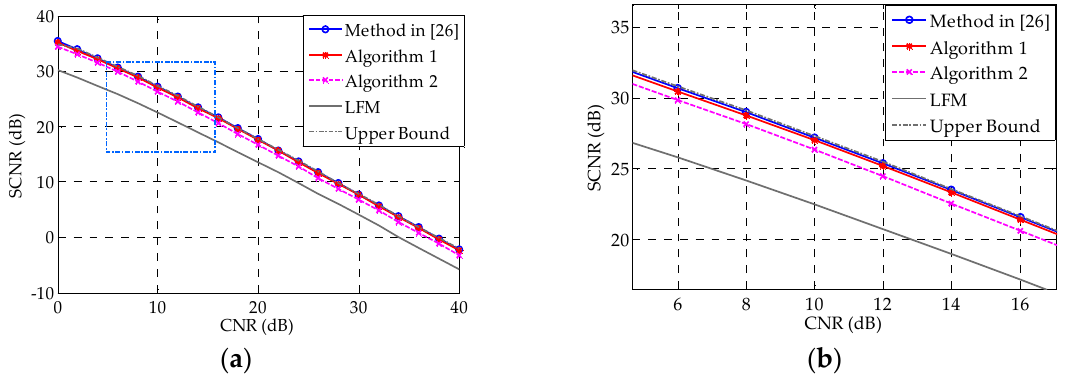
Figure 8. ( a ) Comparison of the SCNR of different methods vs. CNR. The upper bound is the SCNR obtained with 100 iterations of the method in [26], while the blue line marked with circles is obtained with 30 iterations of the same method; ( b ) Zoomed version of the boxed region in ( a ).